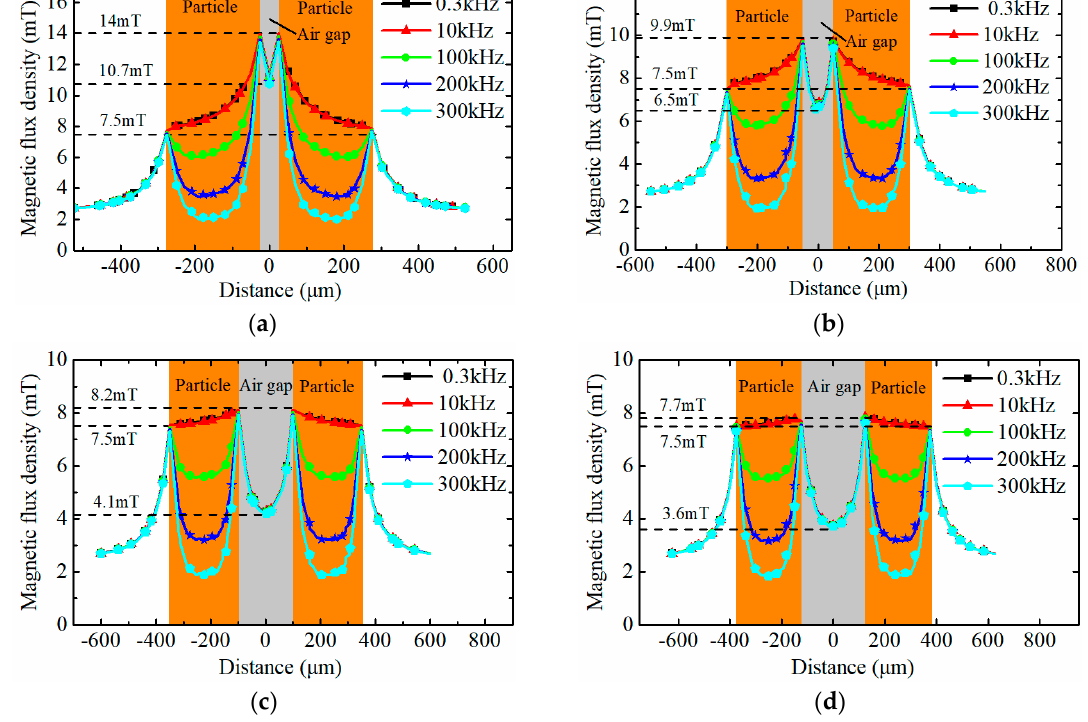
Figure 9. The flux density distribution along the x axis of the dual wear particles system ( a ) l p = 0.4 r a ; ( b ) l p = 0.8 r a ; ( c ) l p = 1.6 r a ; ( d ) l p = 2.0 r a .